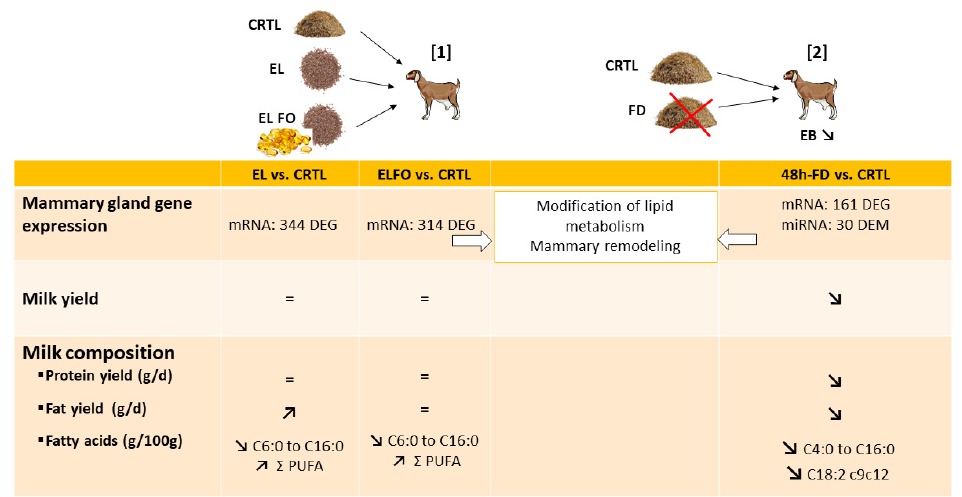
Figure 4. Effects of extruded linseeds (EL) alone or in combination with fish oil (ELFO) supplementa- tion and of 48-h feed restriction (REST) in lactating goats on milk and mammary gene expression. Reprinted with permission from ref. [1] Copyright 2019 Cambridge Core; Reprinted with permission from ref. [2] Copyright 2021 MDPI. CTRL: control diet; DEG: differentially expressed mRNA; DEM: differentially expressed microRNA; EB: energy balance.